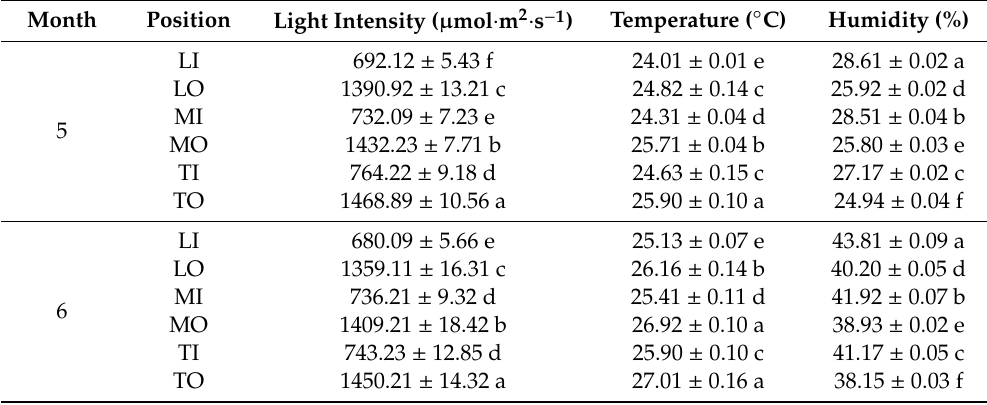
Table 2. Monthly variations in the canopy microclimate of the different positions. Month Position Light Intensity ( µ mol · m 2 · s − 1